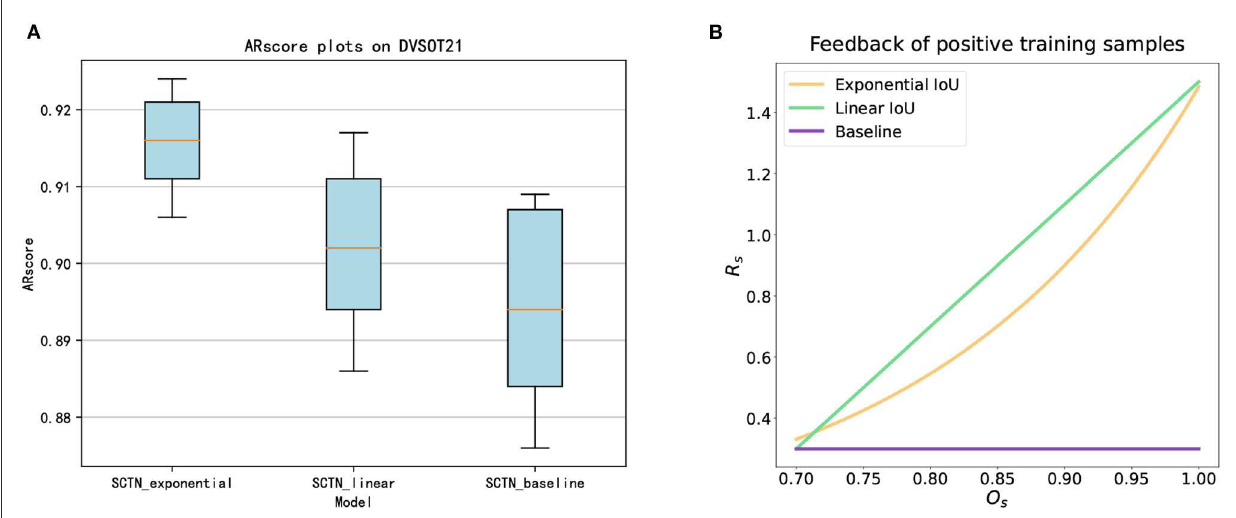
FIGURE7 (A) ARscore plots of three models on DVSOT21, ranked the SCTN with exponential IoU in the loss function, the SCTN with linear IoU in the loss function and the SCTN with basic loss function in descending order of performance. (B) The feedback of positive training samples with three